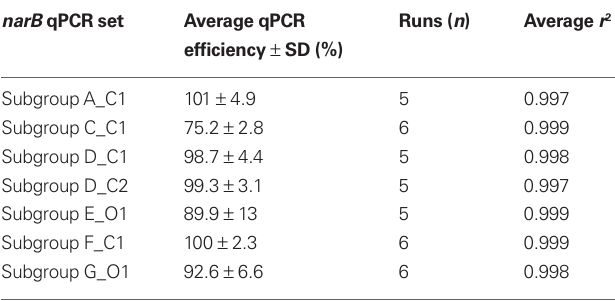
Table 2 | Average reaction efficiency for each narB qPCR assay. narB qPCR